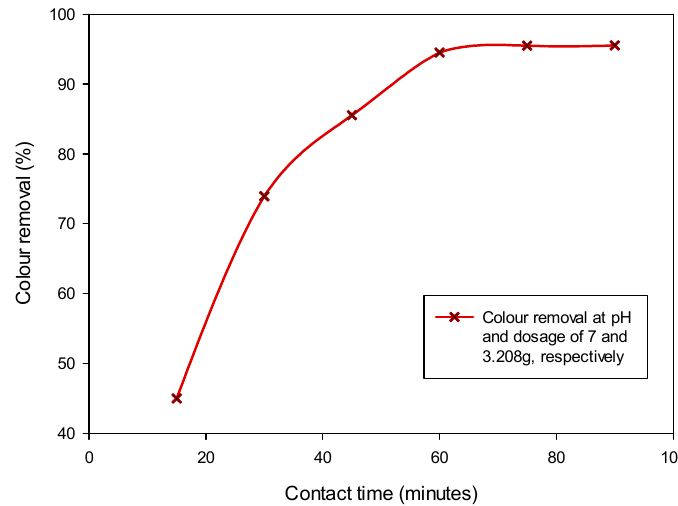
Figure 5. Colour removal from POME under variable contact time at fixed pH and sorbent dosage.